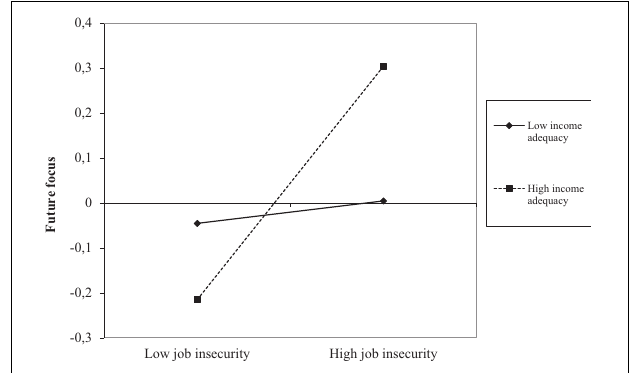
FIGURE 3 | Interaction effect between affective job insecurity and income adequacy on participants’ future